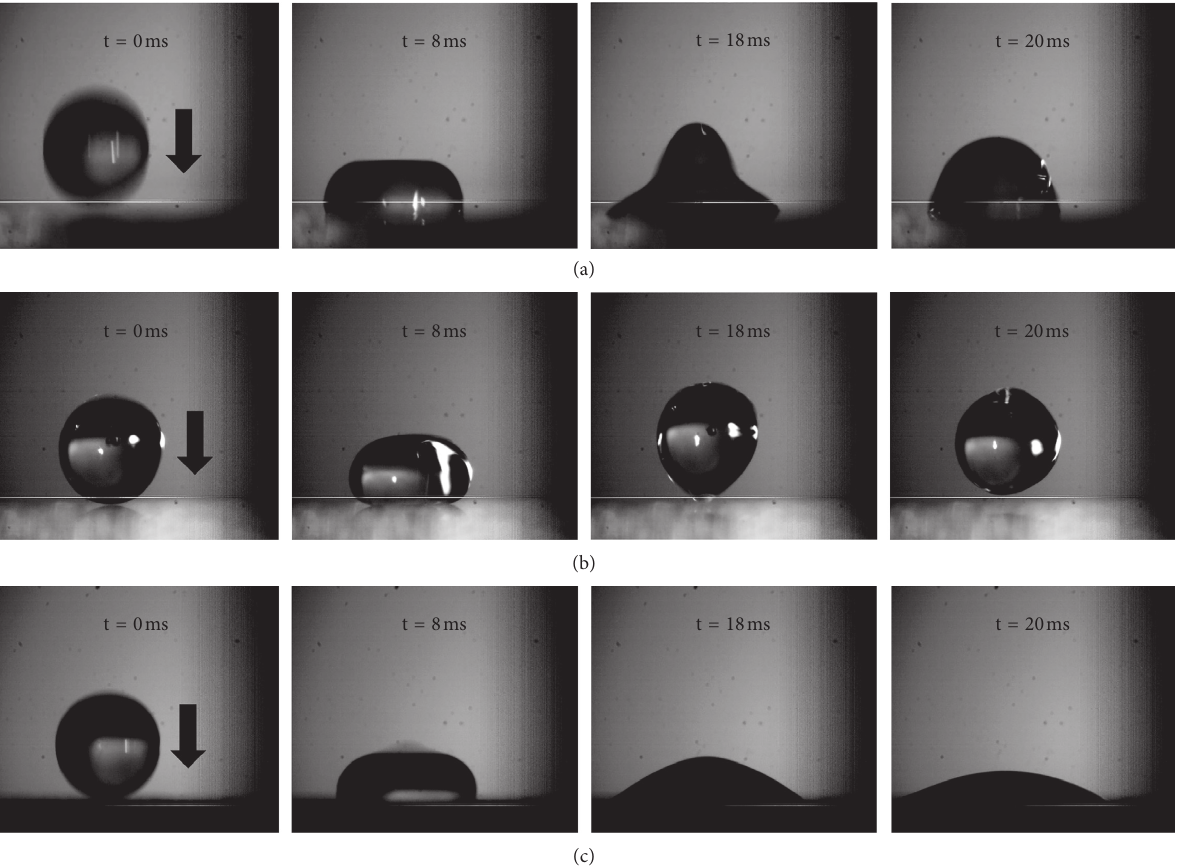
Figure 5: Dynamic behaviors of a falling water droplet on (a) original 304SS, (b) S 1 with superhydrophobic property, and (c) S 6 with hydrophilic